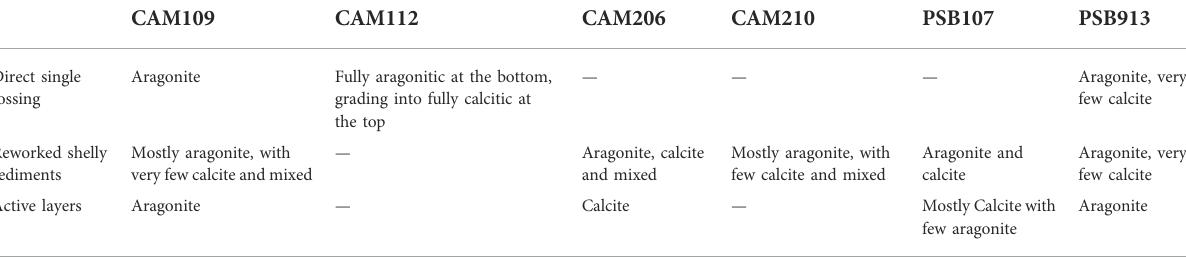
TABLE 3 Shell mineralogy in each type of microfacies per thin section.